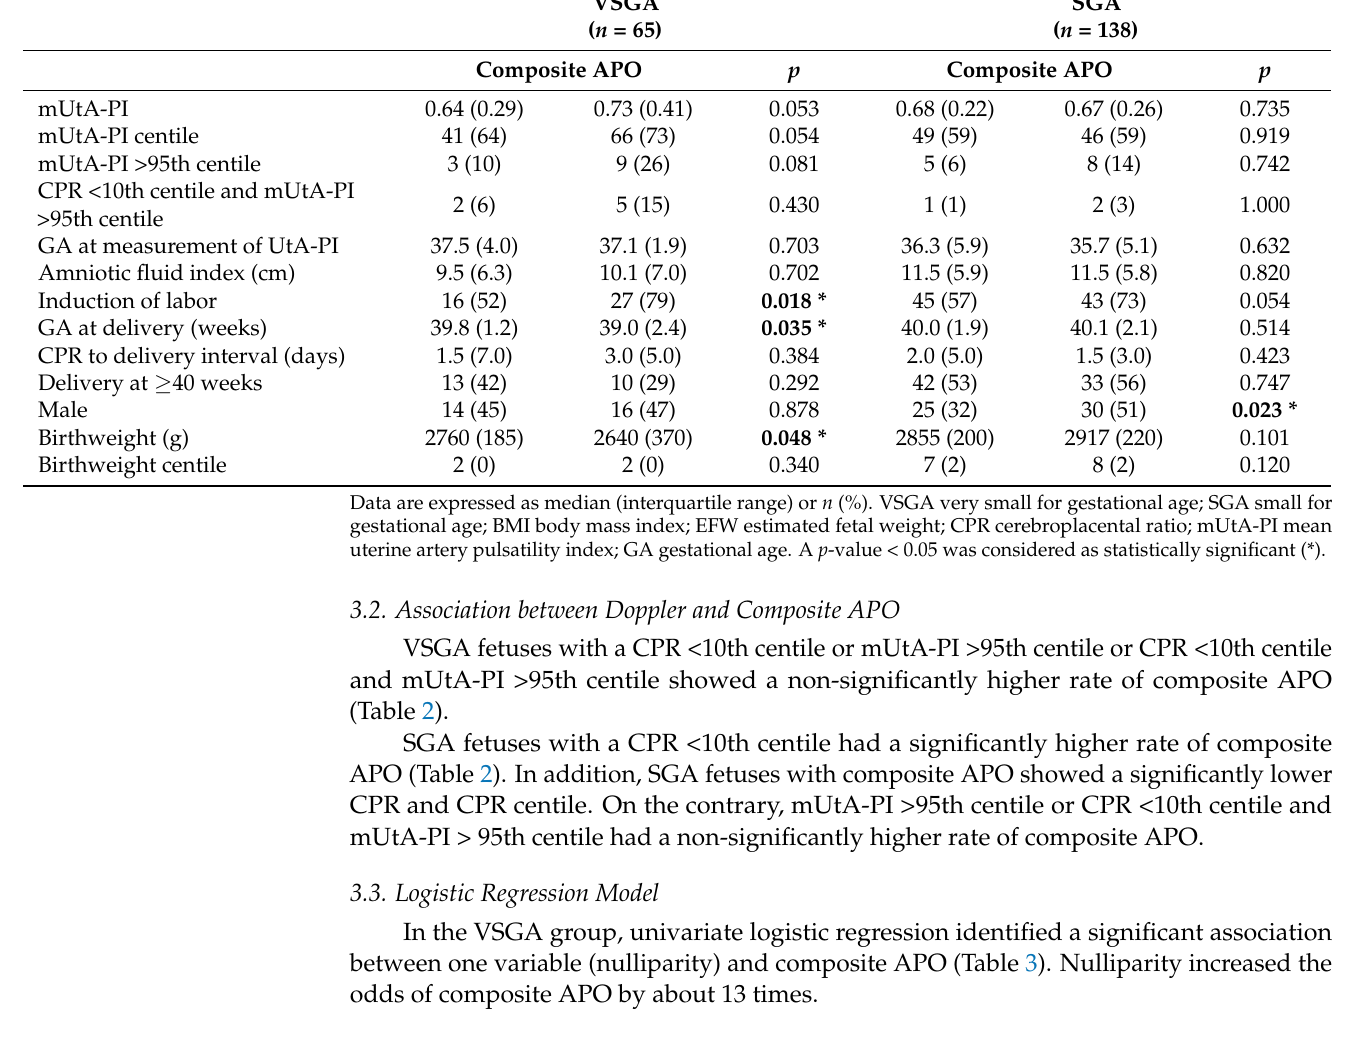
Table 3. Univariate and multivariable logistic regression of predictors of composite adverse perinatal outcome. Variables significantly associated with adverse perinatal outcome in univariate regression ( p < 0.05) were included in the multivariable